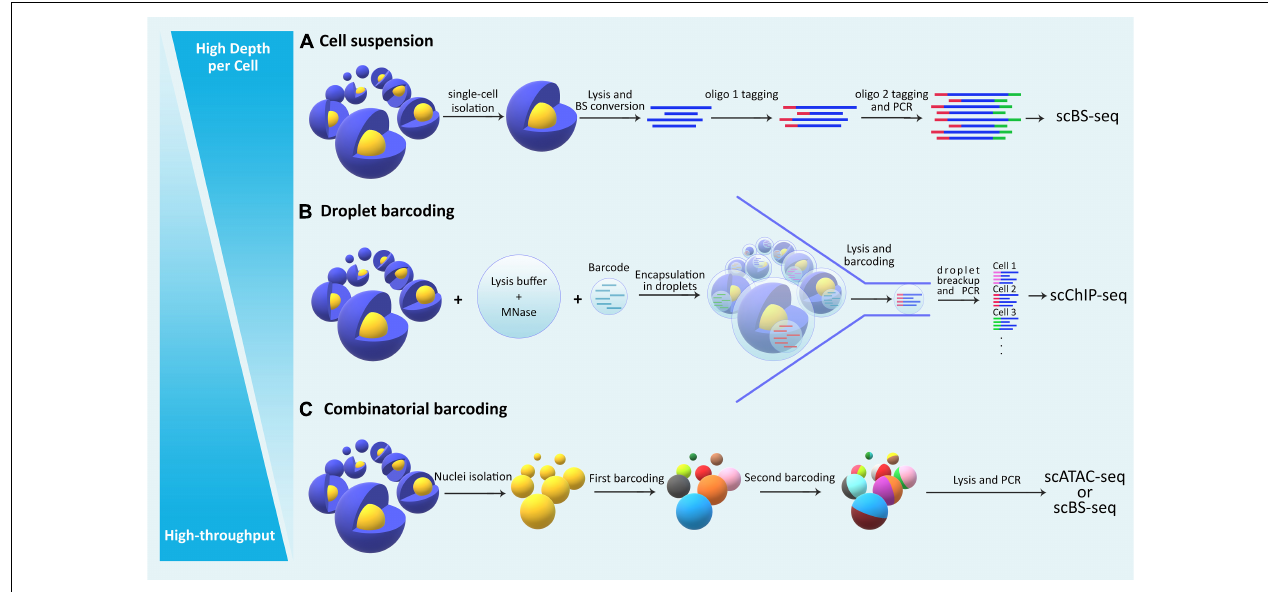
FIGURE 2 | The general categorization of single cell epigenomic assays. (A) Methods that start by dissociating cells in a sample into a single-cell suspension followed by lysis of individual cells in physically separated compartments/reactions, reach high depth of information per cell, but are laborious and expensive and thus offer limited throughput. (B) Droplet based methods allow single-cell identification using barcoding without the need for physical compartmentalization of individual cells, and thus reduce cost and increase throughput. (C) Methods that use combinatorial barcoding on isolated nuclei offer many advantages including higher throughput, albeit in the expense of depth of information per individual